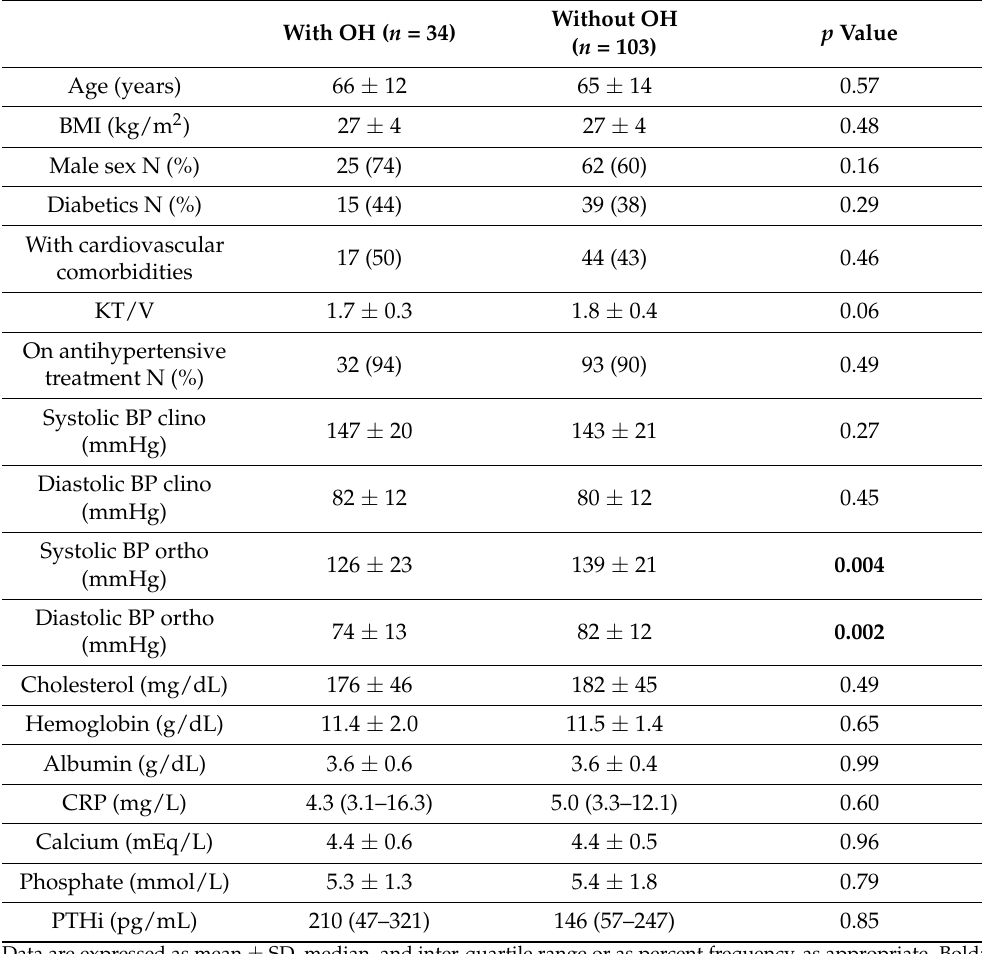
Table 1. Main demographic, somatometric, and clinical characteristics in patients as divided accord- ing to